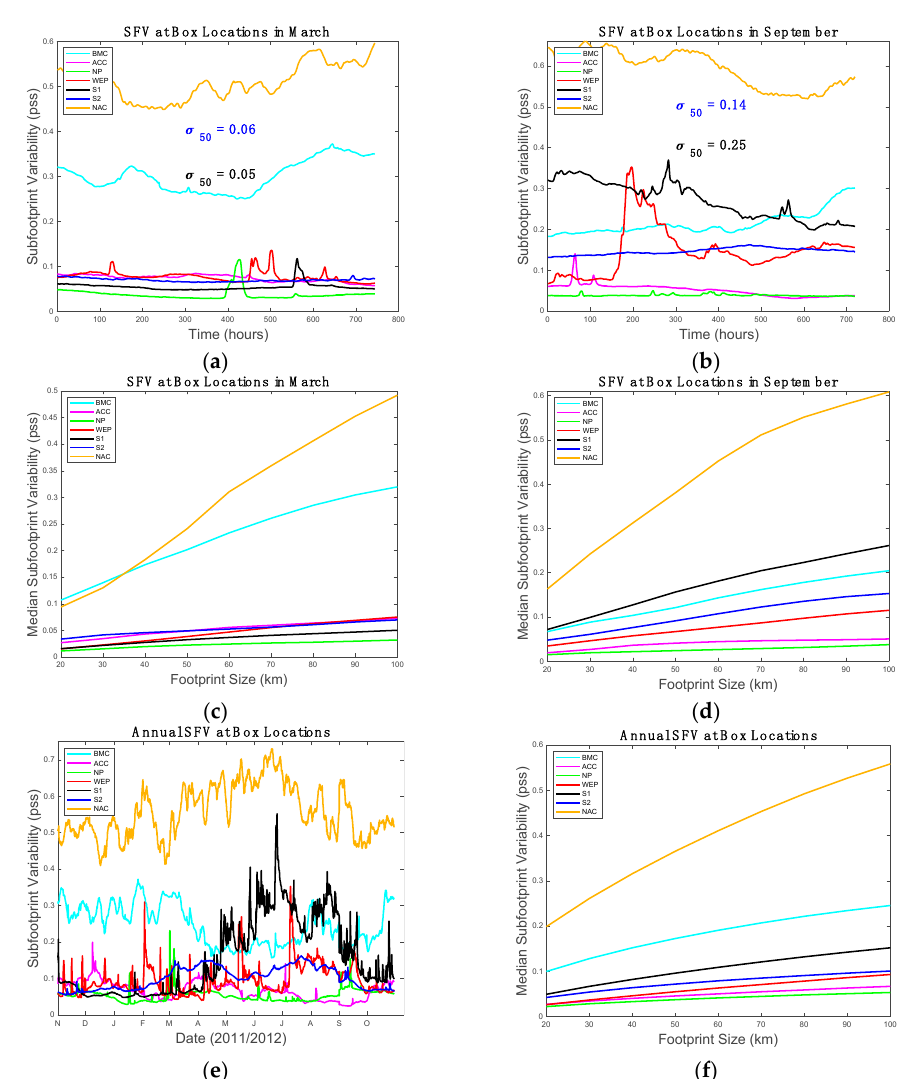
Figure 4. ( a ) SFV for the month of March for 100 km footprint for the locations shown in Figure 2a. The x -axis is in hours starting on 1 March. The legend keys the line color to the box labels as described in the text and shown in Figure 2a. Median values for the SPURS-1 (“S1”) and SPURS-2 (“S2”) over the month are indicated in black and blue fonts, respectively. ( b ) Same as panel ( a ), but for September. ( c ) Median SFV for each location as a function of footprint size for March and ( d ) September, with the same curve labels as in panel ( a ). ( e ) Same as panel ( a ), but for the full year. ( f ) Same as panel ( c ), but for the full year. Note the variations in vertical axis limits between panels.